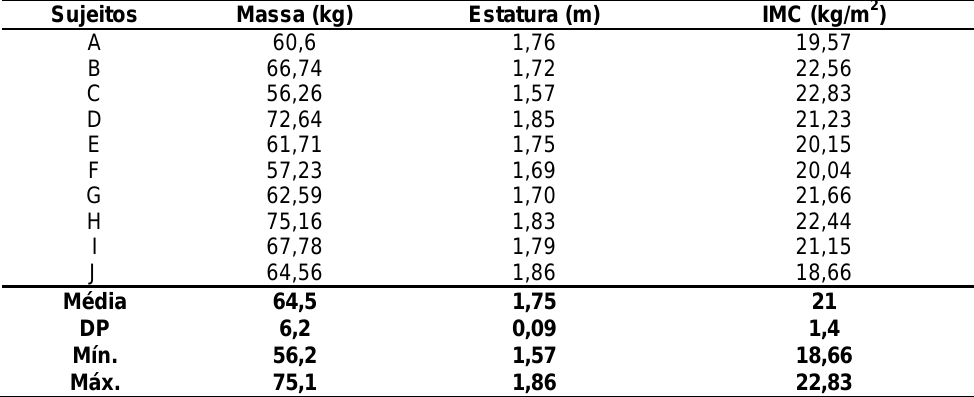
Tabela 2. Dados antropométricos das pessoas com lesão da medula espinhal.